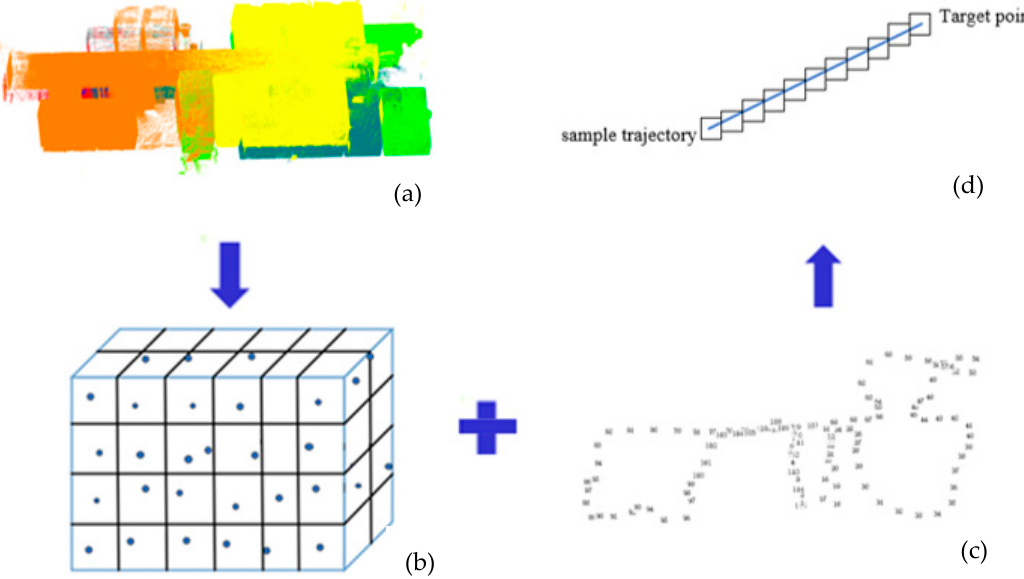
Figure 3. The diagram of visible point clouds of simulated trajectory points. ( a ) Original point clouds. ( b ) Original point clouds divided into uniform grids. ( c ) Sample trajectory points. ( d ) Visibility analysis based on line-of-sight.